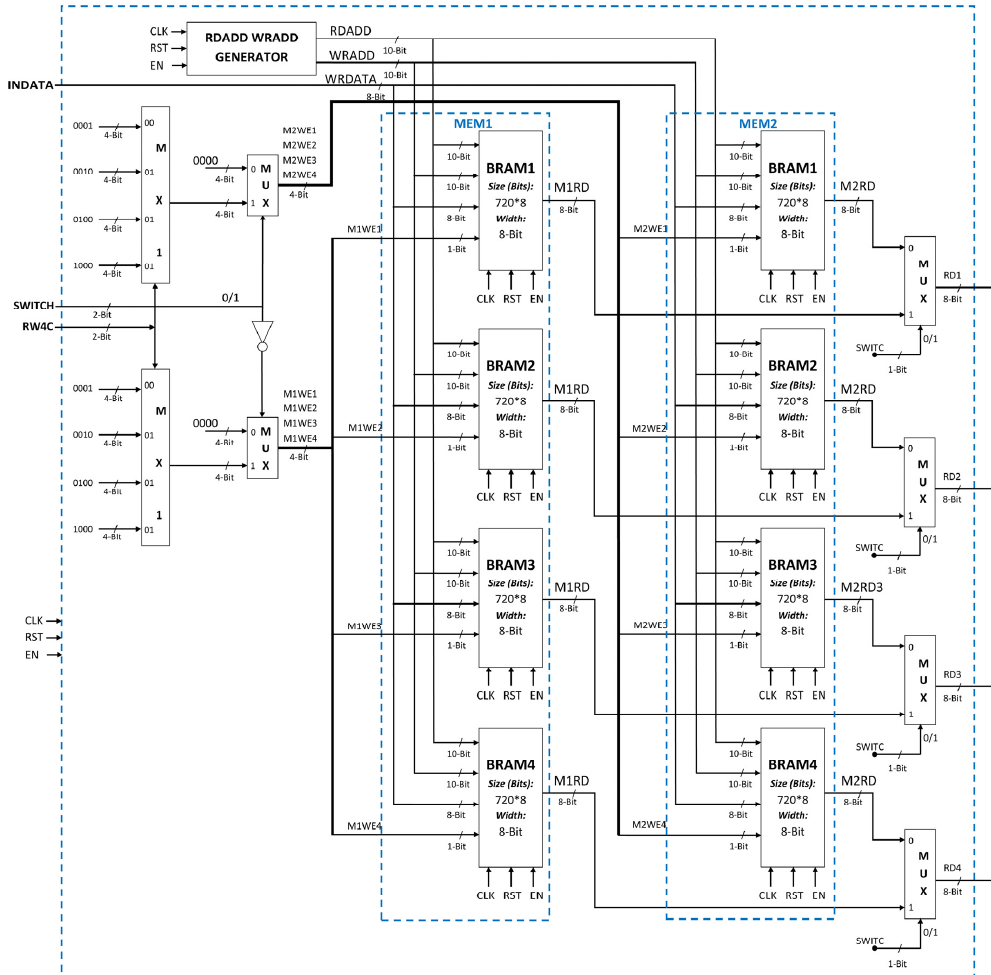
Figure 5. Proposed VLSI architecture for Input Buffer Memory.